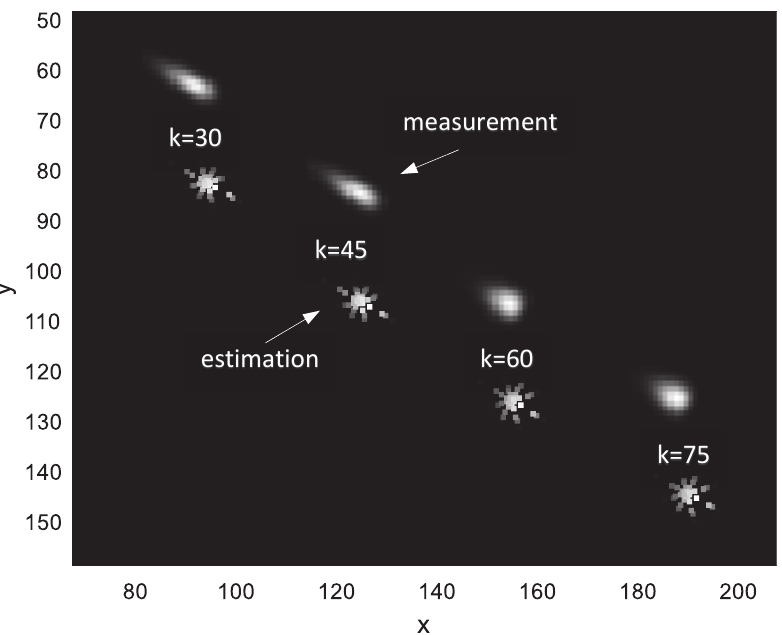
Figure 4. Snapshots of tracking at time step k = 30, 45, 60 and